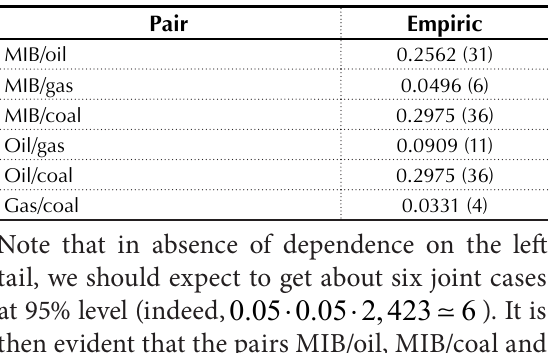
Table 3. Left tail parameter estimation for each pair of variables (number of cases between parentheses) at 95% level